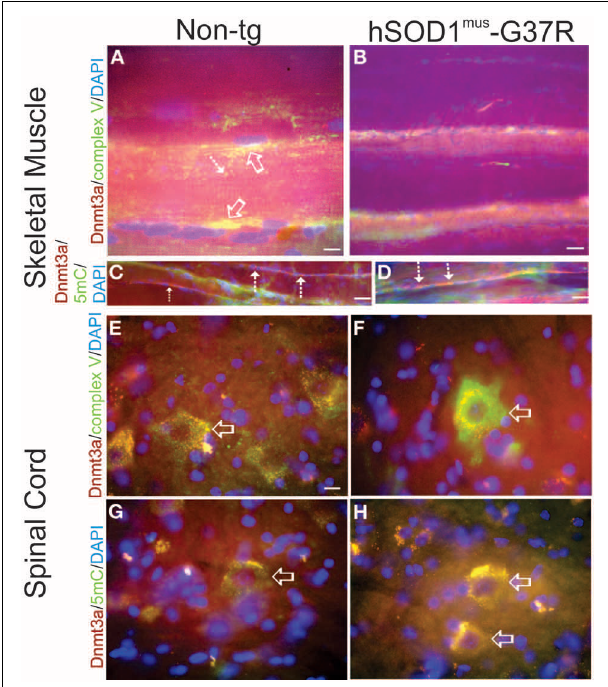
FIGURE 5 | Immunofluorescent localizations of Dnmt3a, mitochondria, and 5-methylcytosine (5mC) in hSOD1 mus tg mouse skeletal muscle and spinal cord. (A,B) In non-tg mouse skeletal muscle (biceps femoris), Dnmt3a (red) immunoreactivity can be found diffusely in the sarcoplasm and associated with mitochondria (colocalization is seen as yellow) identified by complex V immunoreactivity (green). Dnmt3a/complex V colocalization occur prominently in subsarcolemmal mitochondria in non-tg mice (A, open arrows) and in interfibrillar mitochondria (A , hatched arrow ) . In hSOD1 mus mouse hindleg skeletal muscle, Dnmt3a (red) immunoreactivity and mitochondrial complex V immunoreactivity (green) are markedly attenuated. Scale bars = 9 µ m (A) , 15 µ m (B) . (C,D). Myofiber perinuclear colocalization of Dnmt3a and 5mC is intensified in hSOD1 mus tg mice. In non-tg mouse skeletal muscle (biceps femoris), Dnmt3a (red) immunoreactivity can be found clustered around peripheral myonuclei (C , hatched arrows ) and generally has little colocalization with 5mC. In hSOD1 mus mouse skeletal muscle Dnmt3a (red) and 5mC (green) immunoreactivities have prominent perinuclear colocalizations (D , hatched arrows, yellow-orange ) . Scale bars = 20 µ m (C,D) . (E,F) In ∼ 17 months old non-tg mice, Dnmt3a immunoreactivity (red) is present in the nucleus and, more prominently, in the cytoplasm of spinal cord motor neurons (E,G , open arrows ) . Cytoplasmic Dnmt3a immunoreactivity (red) is localized in discreet particles in motor neurons (E , G , arrows ) . Many of these cytoplasmic particles colocalize (seen as yellow) with complex V immunoreactivity (E , green ) , and thus are mitochondria, and with 5mC (G , green, arrow ) and thus contain methylated mtDNA. Scale bar in (E) ( same for F–H) = 6 µ m. In age-matched hSOD1 mus tg mice, remaining spinal motor neurons (F , open arrow ) show intensified mitochondrial immunoreactivity for complex V (green) and the Dnmt3a immunoreactivity largely is colocalized with complex V (F) and 5mC (H) and is aggregated in the